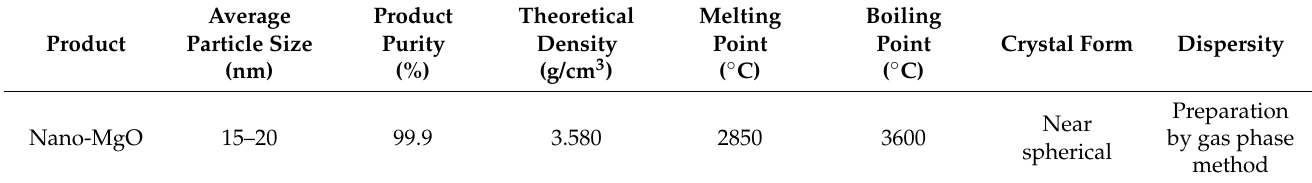
Table 3. Nano-MgO physical parameters [22].